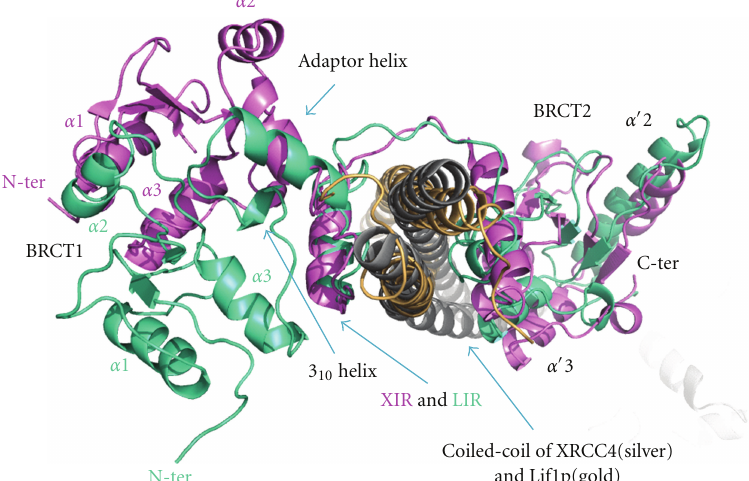
Figure 13: Comparison of positions of BRCT1 between LigIV/XRCC4 and Lif1p/Lig4p. Structures of LigIV/XRCC4 (violet/silver) and Lifp1/Lig4p (green/gold) were superimposed based on XIR and LIR. The figure is a view of the C- to N-terminal direction of the coiled-coils of XRCC4 and Lif1p. The N-terminals and helices of BRCT1 of LigIV and Li4p are labeled with violet and green,